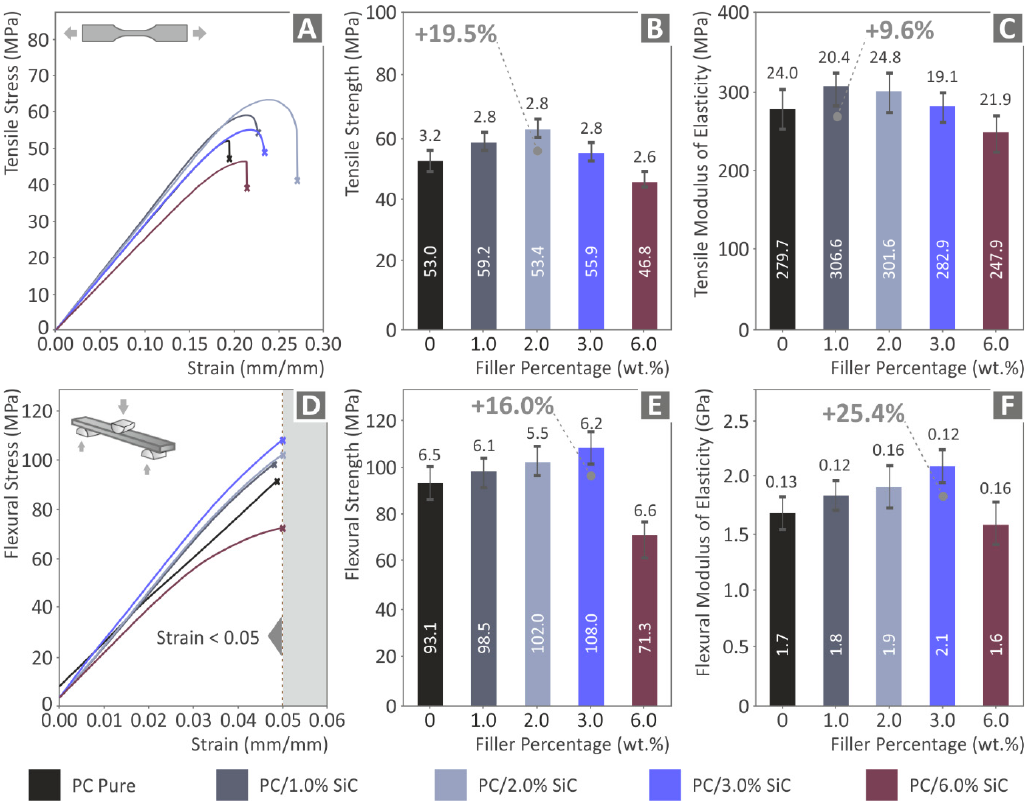
Figure 6. Experimental results of the tensile and the flexural tests (tests were terminated at 5% strain, in accordance with the instructions of the ASTM D790 standard): ( A ) stress compared with strain graphs, ( B ) mean calculated tensile strength and the corresponding calculated deviation out of the five samples tested ( C ) mean calculated tensile modulus of elasticity and the corresponding calculated deviation out of the five samples tested, ( D ) stress compared with strain, ( E ) mean calculated flexural strength, and the corresponding calculated deviation out of the five samples tested, and ( F ) mean calculated flexural modulus of elasticity and the corresponding calculated deviation out of the five samples tested.